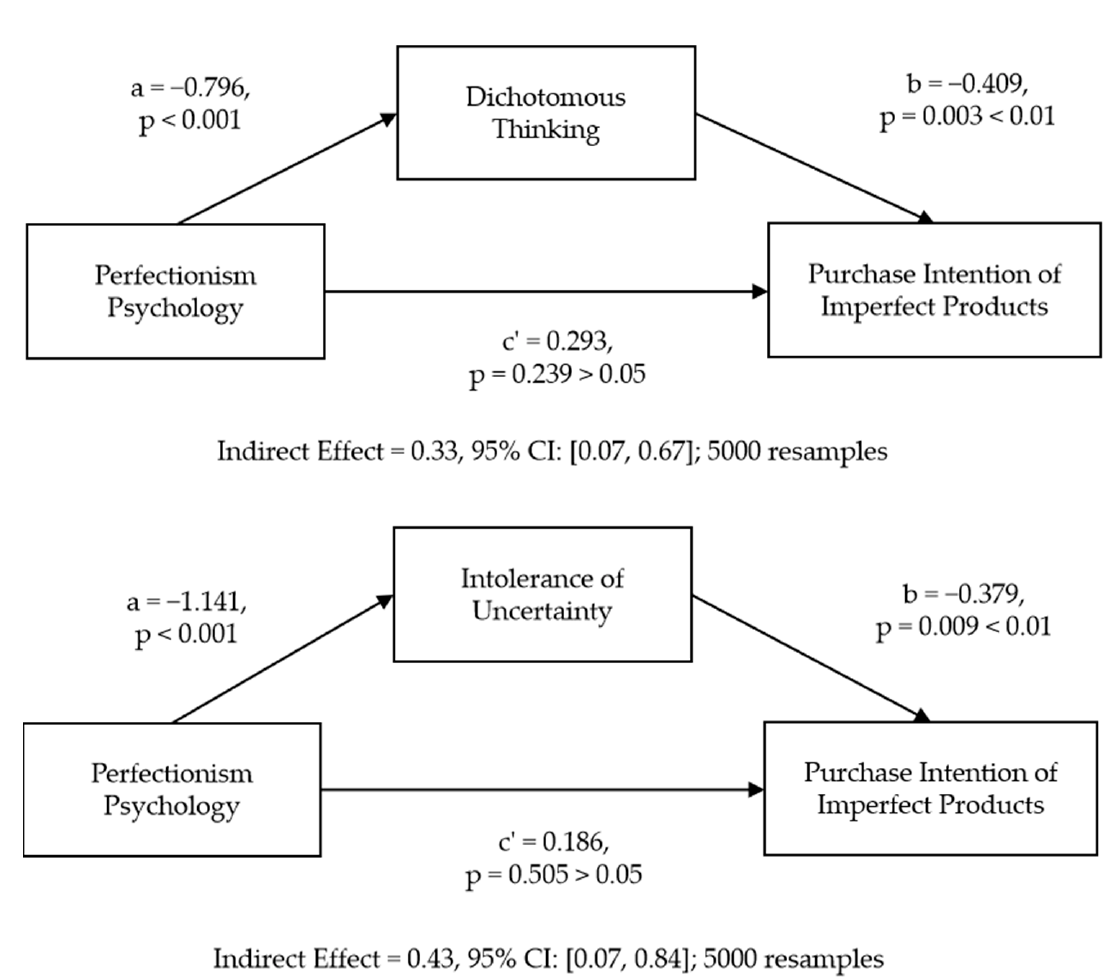
Figure 4. Mediating role of dichotomous thinking and intolerance of uncertainty.